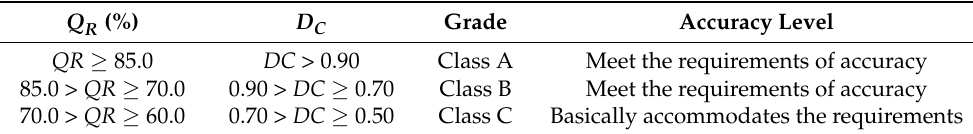
Table 8. Accuracy assessment and inspection grading